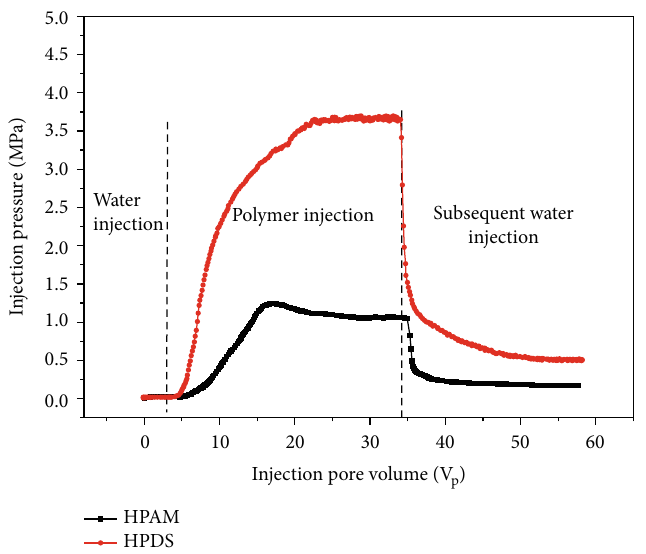
Figure 13: Relationship between injection pressure and injection pore volume.